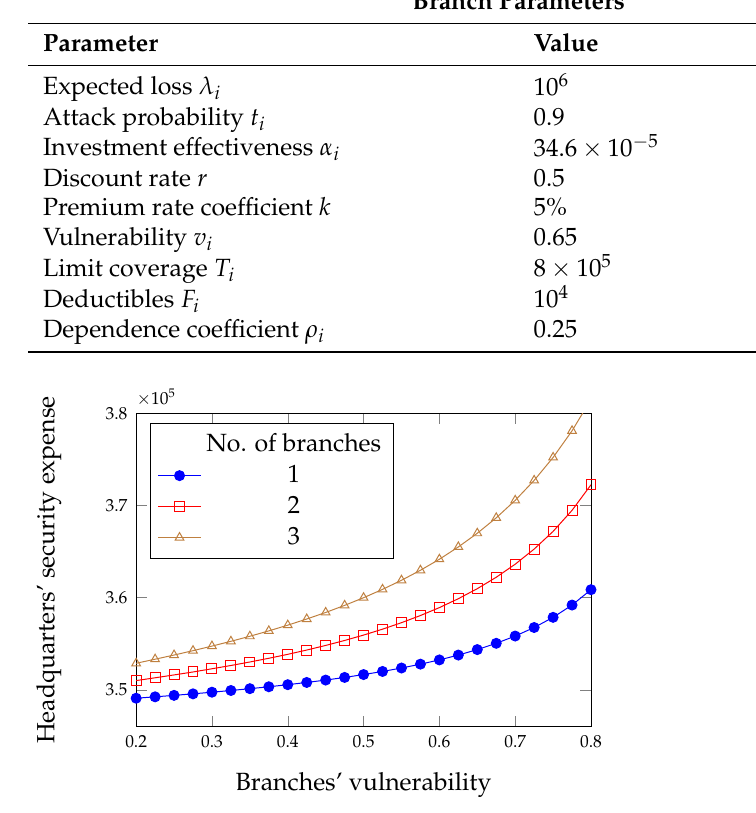
Figure 3. Overall security expense of the headquarters for the full liability